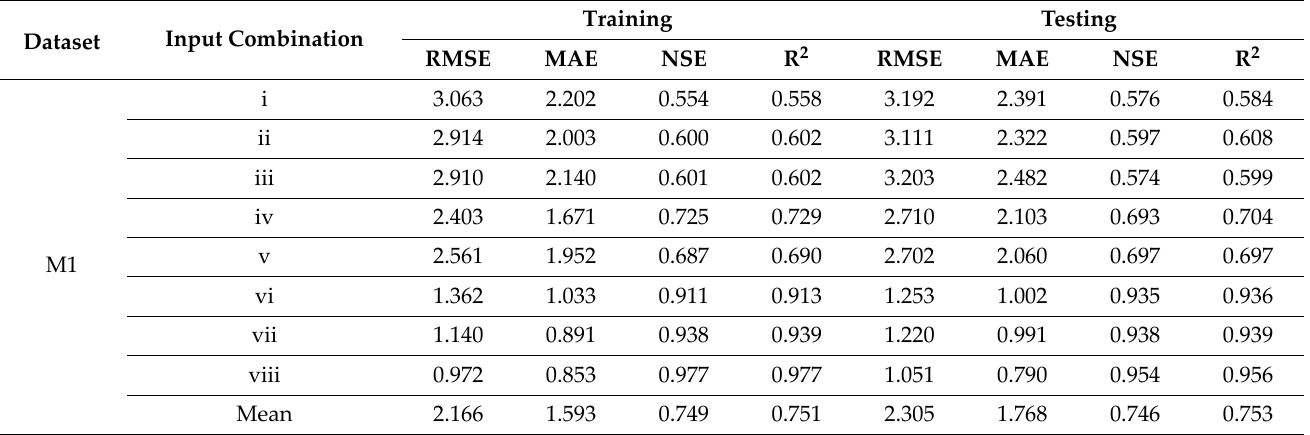
Table 5. The results of the model RVFL‑MFO for monthly time